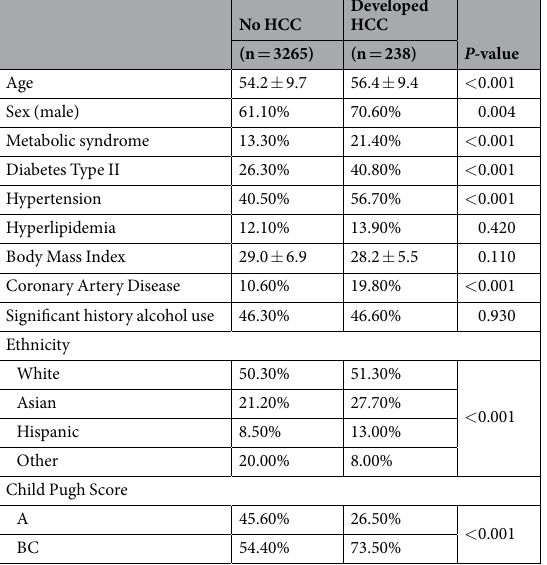
Table 2. Baseline clinical characteristics for 3503 patients with HCV cirrhosis by HCC status. Abbreviations: HCC, hepatocellular carcinoma; HCV, hepatitis C virus.